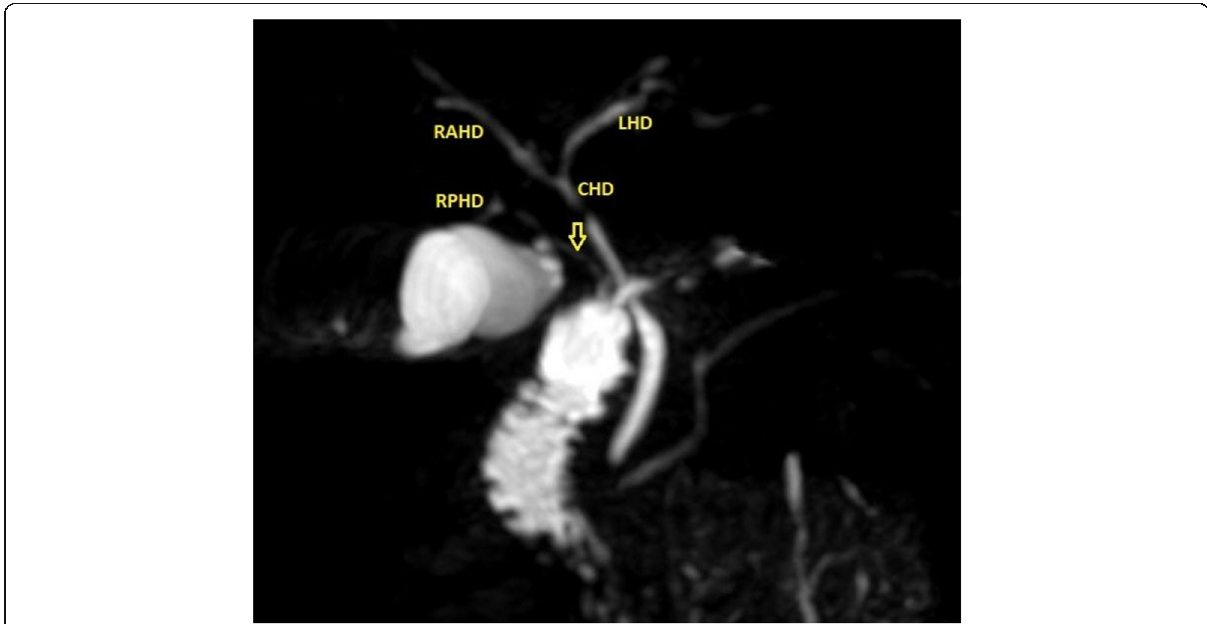
Fig. 7 MRC 3D TSE. Huang type A5: RPHD drains into cystic duct (arrow) (RAHD, right anterior hepatic duct; LHD, left hepatic duct; MHD, main hepatic